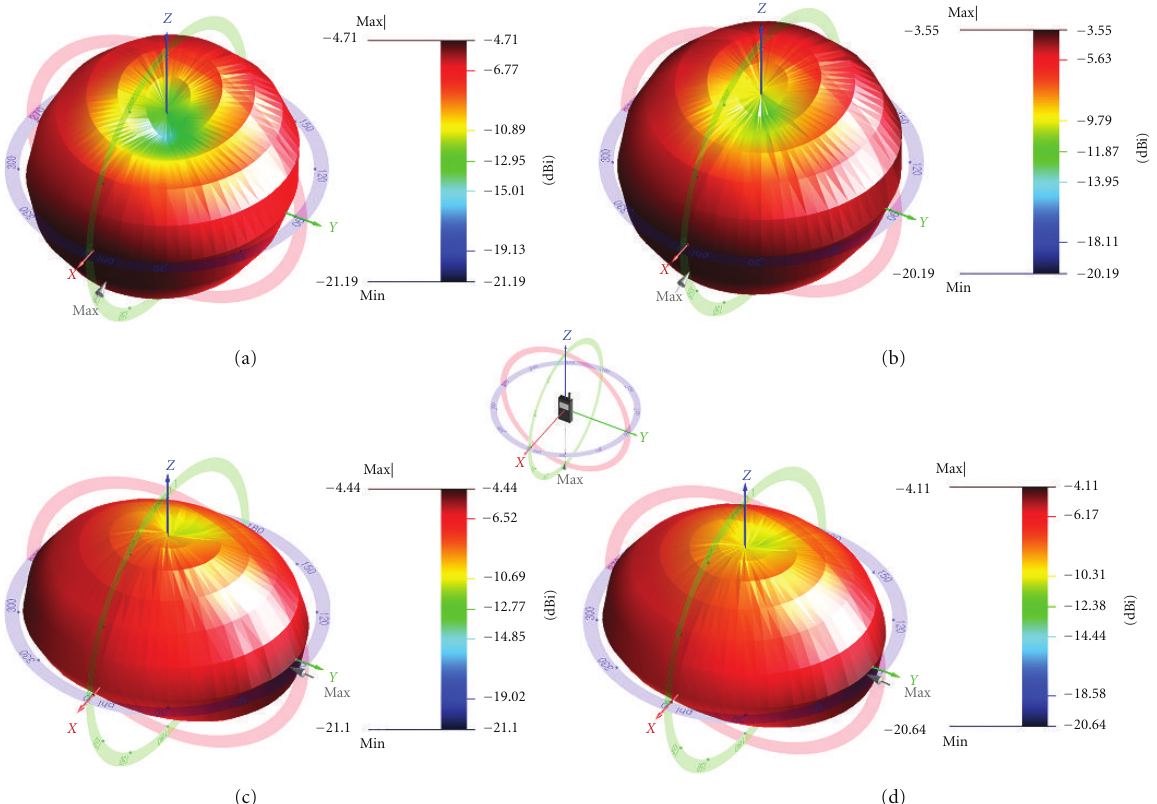
Figure 13: Measured radiation patterns: (a) element number 1 at 0.756 GHz, (b) element number 1 at 0.777 GHz, (c) element number 2 at 0.756 GHz, and (d) element number 2 at 0.777